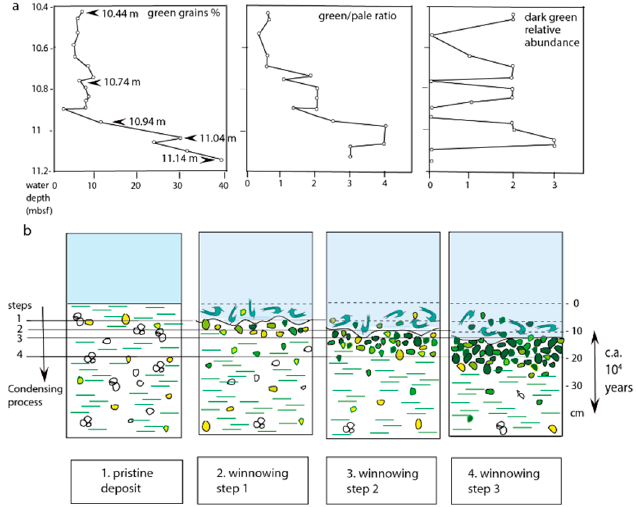
Figure 13. ( a ) 959 ODP Site. Example of green-grain vertical distribution between 11.2 and 10.4 mbsf: green-grain concentration, green–white grain ratio, dark-green (cracked) grain relative abundance. ( b ) Step-by-step condensation process of the green grains. Bottom-current-controlled green-grain deposition and evolution, based on mud-matrix reworking, green grains’ mechanical concentration, and mineralogical maturation, reflecting the time of residence of the grains at the sea bottom before burial. Foraminifer tests were gradually removed or destroyed from 1 to 3, after [5].